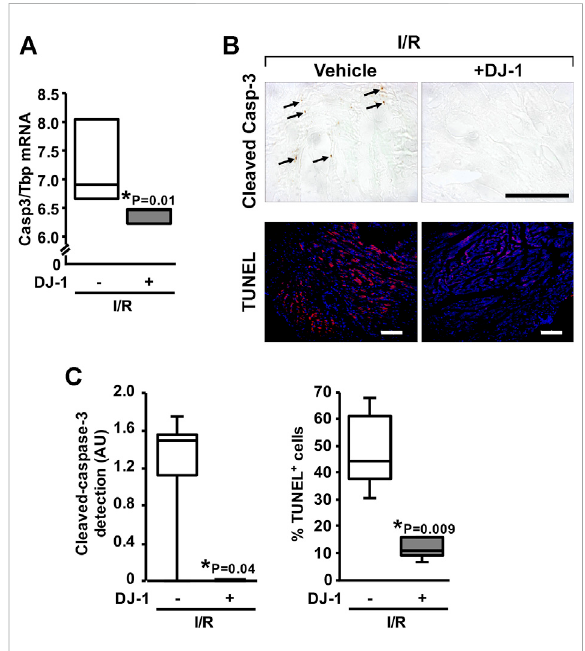
FIGURE 4 Effects of DJ-1 systemic administration on myocardial apoptosis after ischemia/reperfusion. (A) Casp3 transcript analysis by qPCR. (B) Representative acquisitions of myocardial cleaved Casp-3 immunohistochemistry (upper panel) and TUNEL assay (lower panel) after ischemia/reperfusion. (C) myocardial cleaved Casp-3 immunohistochemistry and TUNEL positive